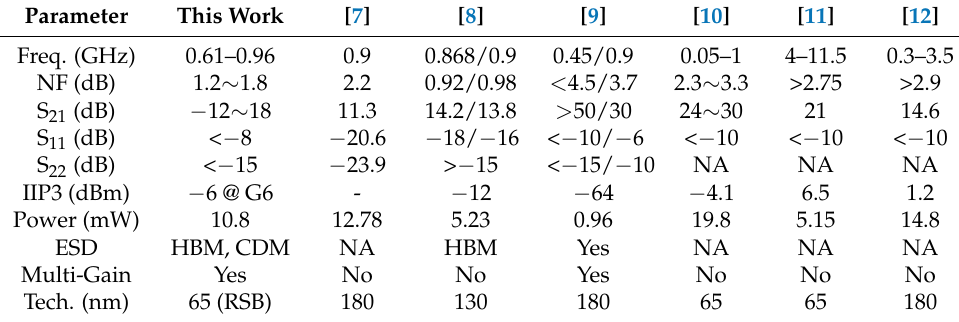
Figure 10. Phase discontinuity in an example frequency of 892 MHz. Table 1. Performance summary and